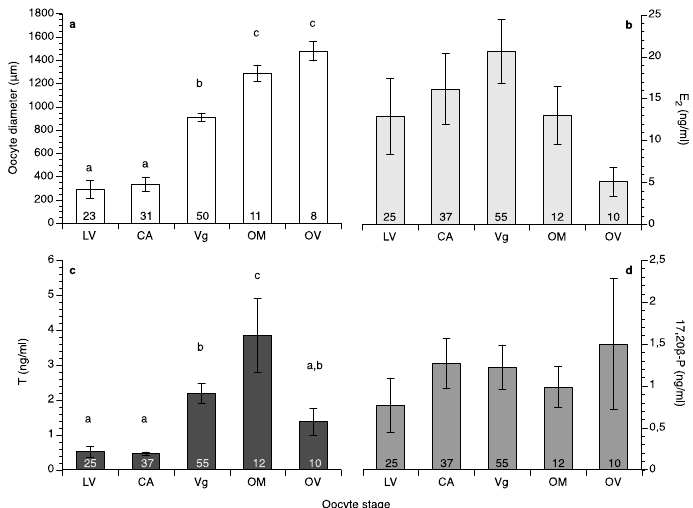
Figure 4. Mean ( ± standard error of the mean (SEM)) oocyte diameter ( a ), concentrations of 17 β -estradiol (E 2 ), ( b ), testosterone T, ( c ) and 17,20 β -dihydroxy-progesterone (17,20 β -P), ( d ) at different stages of oocyte development of wreckfish kept in captivity (LV: lipid vesicle, CA: cortical alveoli, Vg: vitellogenesis). Different letter superscripts indicate statistically significant differences among oocyte stages (one-way analysis of variance (ANOVA), Tukey’s Honest Significant Difference (HSD) test, p < 0.05). The numbers inside the bars indicate the number of females sampled at each stage. The numbers inside the oocyte diameter bars represent the number of wet mount biopsies measured, whereas the numbers inside the sex steroid bars represent the number of females sampled, including those who were staged after histological processing of their biopsies.